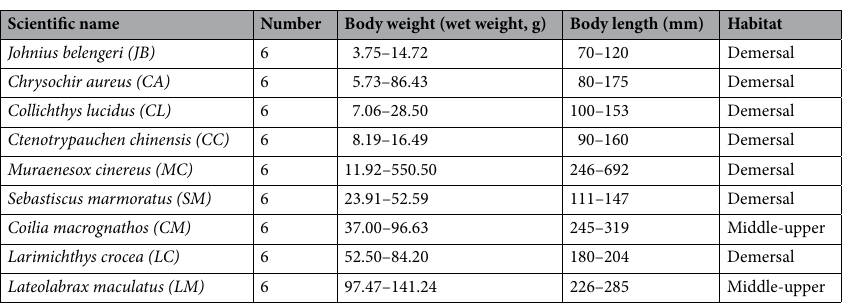
Table 1. Characteristics of fish species from Dachen fishing ground. ww wet